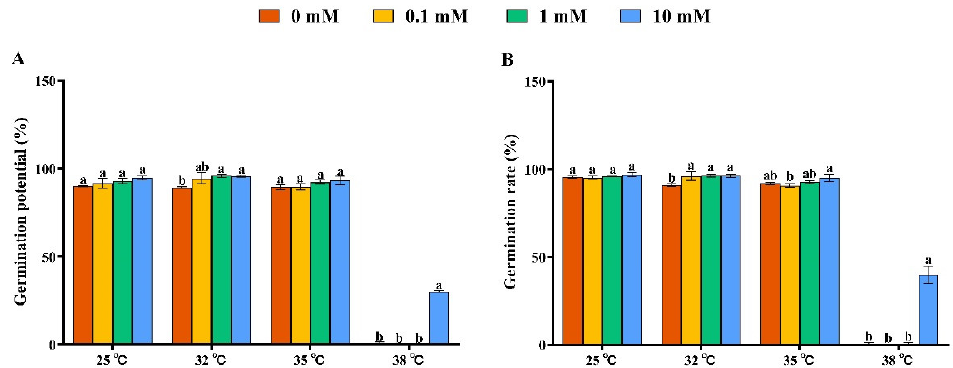
Figure 1. Effects of soaking seeds with different concentrations of betaine at 25 °C, 32 °C, 35 °C and 38 °C on germination characteristics of rice seeds. The difference in the average value of each letter indicates that there is a significant difference in the parameters ( p < 0.05): ( A ) germination potential; ( B ) germination rate.